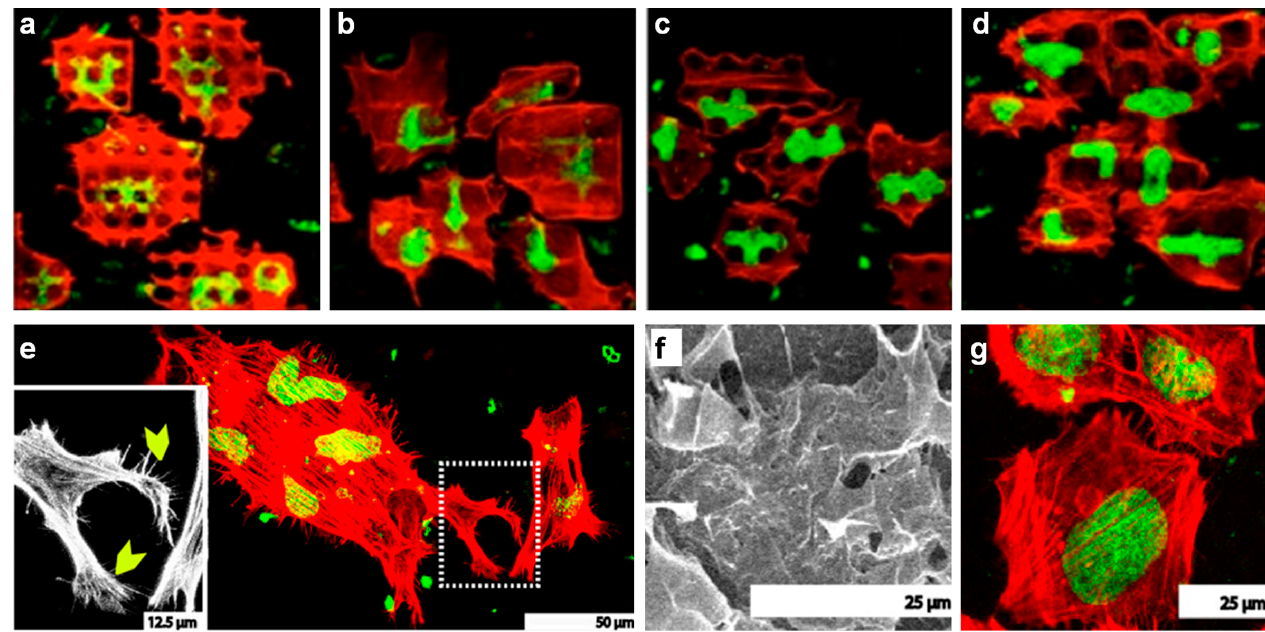
Figure 6. Schematics depicting various parameters that can be controlled within specific topogra- phies and the resulting effects on neural cells: ( a ) continuous topographies represented by grooves of various dimensions are able to affect the direction of cell outgrowth and polarity; ( b ) discontinu- ous topographies such as pillars of different shape, size and arrangements can alter the adhesion, survival and differentiation of neural cells. Adapted with permission from ref. [129].